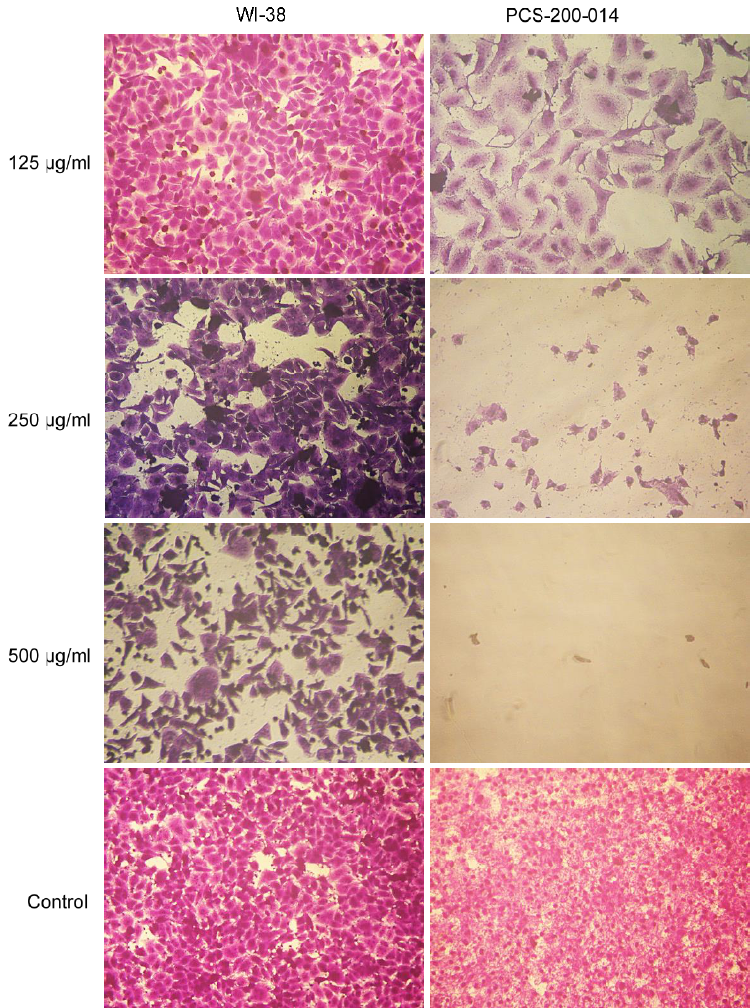
Figure 5. Morphological changes in WI-38 and PCS-200-014 cells after exposure to a crude extract of combined Alternaria mycotoxins (ALT, AOH, TeA, and AS) at concentrations of 125, 250, and 500 µg/mL for 24 h.